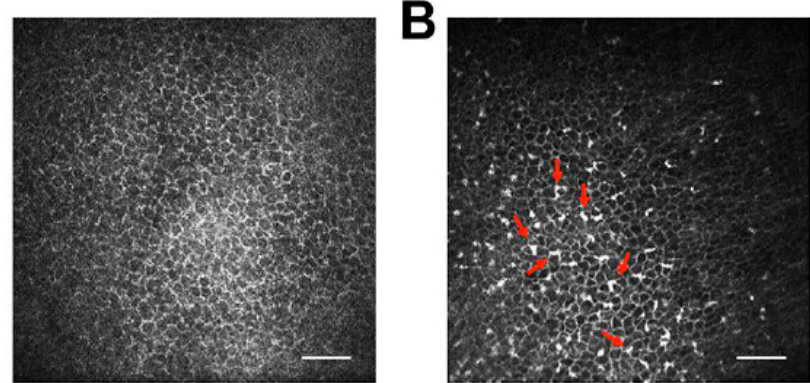
Figure 5. In vivo confocal microscopy of canine corneas. Representative confocal photomicrographs of the cornea of an uninfected dog ( A ) and following ocular CHV-1 infection at day 10 post infection ( B ). Note the corneal infiltration with leukocytes following virus infection, which appear as highly reflective, irregularly shaped white cells within the corneal epithelium (see arrows). In vivo confocal microscopy of cats yields similar photomicrographs. Scale bar, 50 µm.